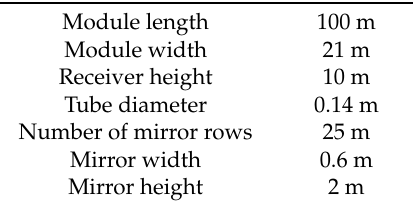
Table 3. Main parameters of the LFR.